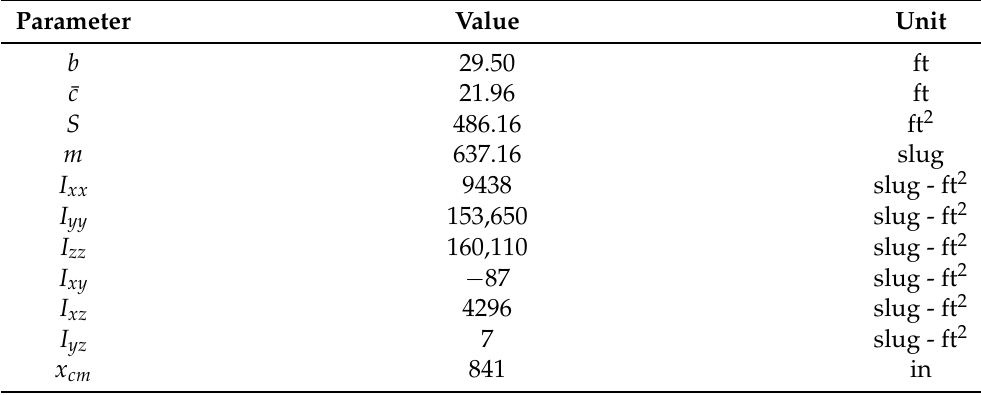
Figure 7. A rendering of the X-59 airplane in flight. Table 2. The geometry and mass properties of the X-59 in flight condition